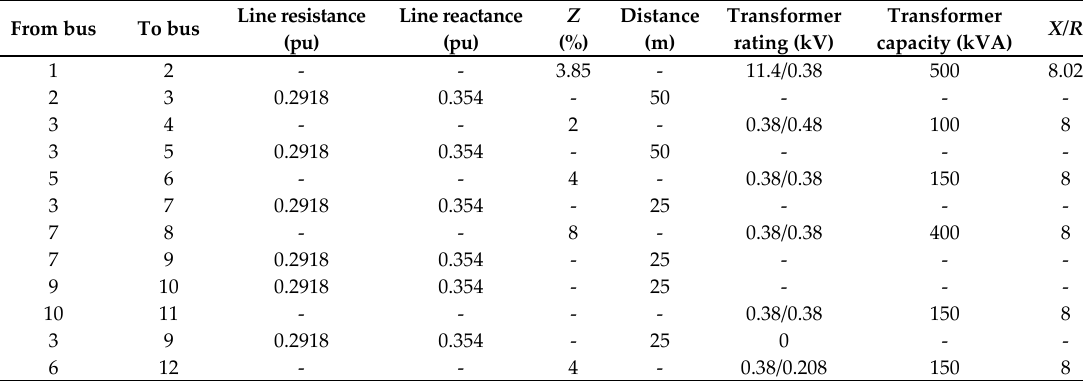
Figure 9. Single line diagram of the Institute of Nuclear Energy Research (INER) microgrid. Table 3. Line data of the INER